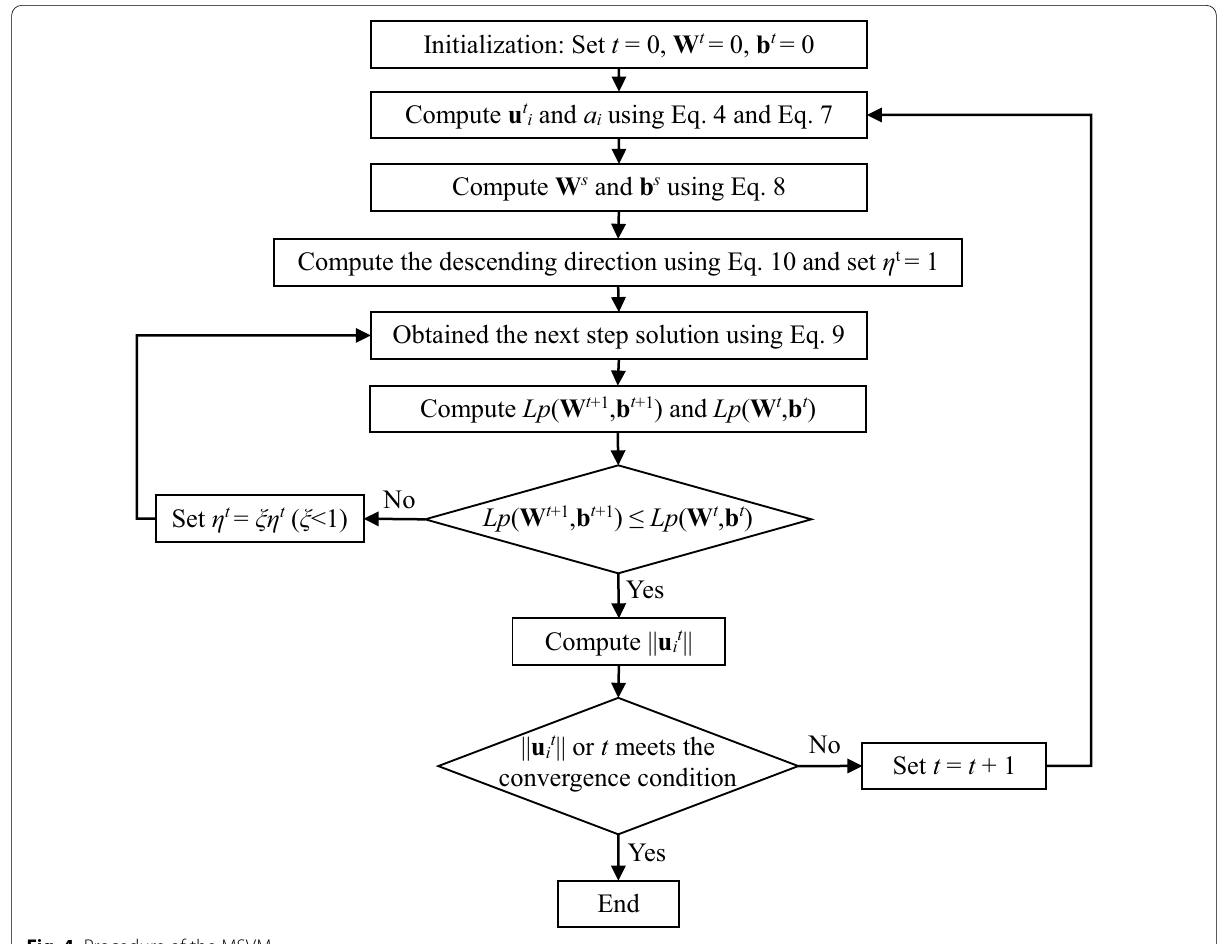
Fig. 4 Procedure of the MSVM